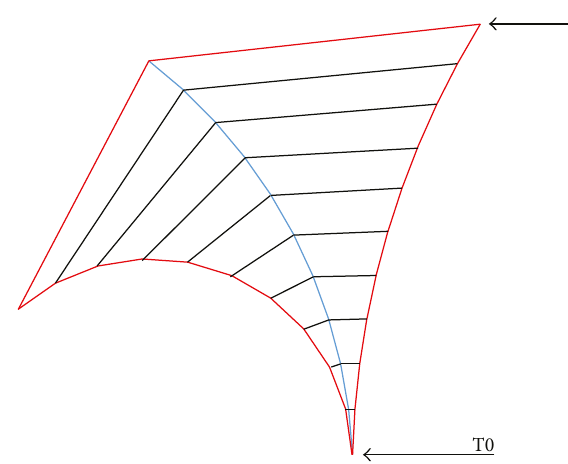
Figure 4: STS schematics with turning